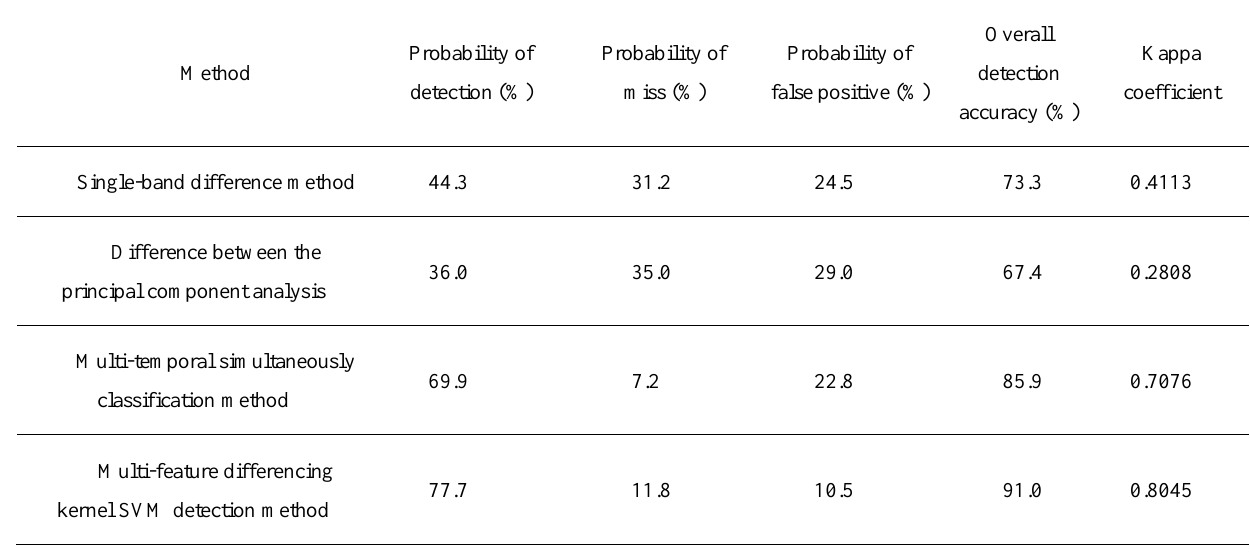
Tabel.2 Accuracy of four change detection